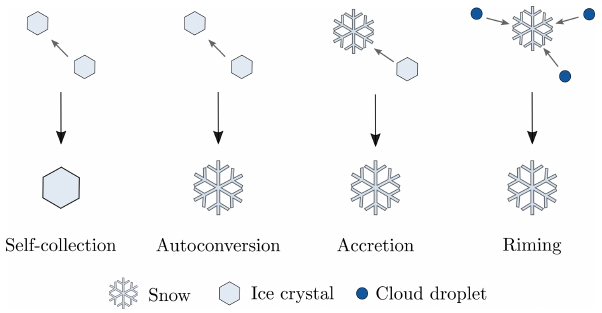
Figure 1. The four cloud microphysical processes investigated in this study, depicted as they are represented in